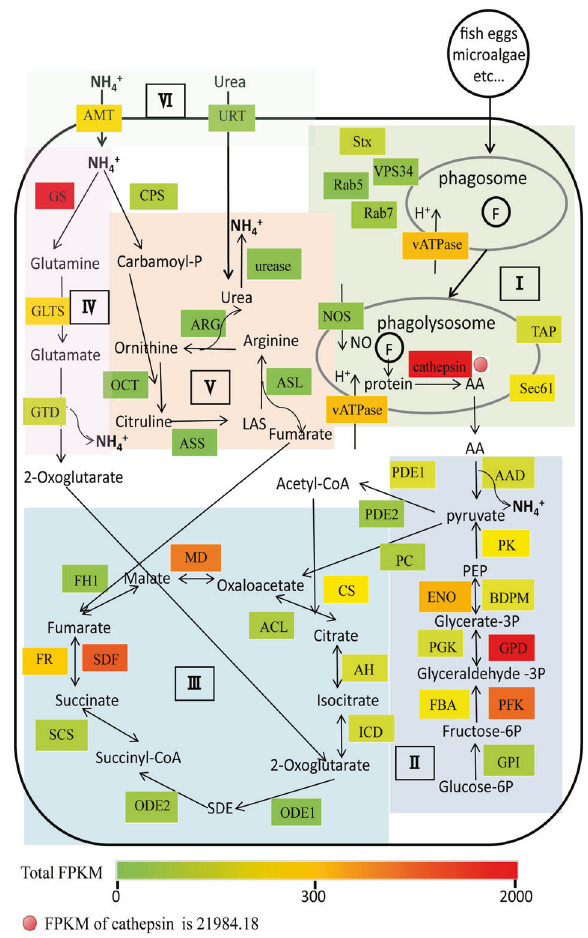
Fig. 3 Highly expressed genes (top 25%) and their related metabolic processes in g Noctiluca . I Phagocytosis metabolism.